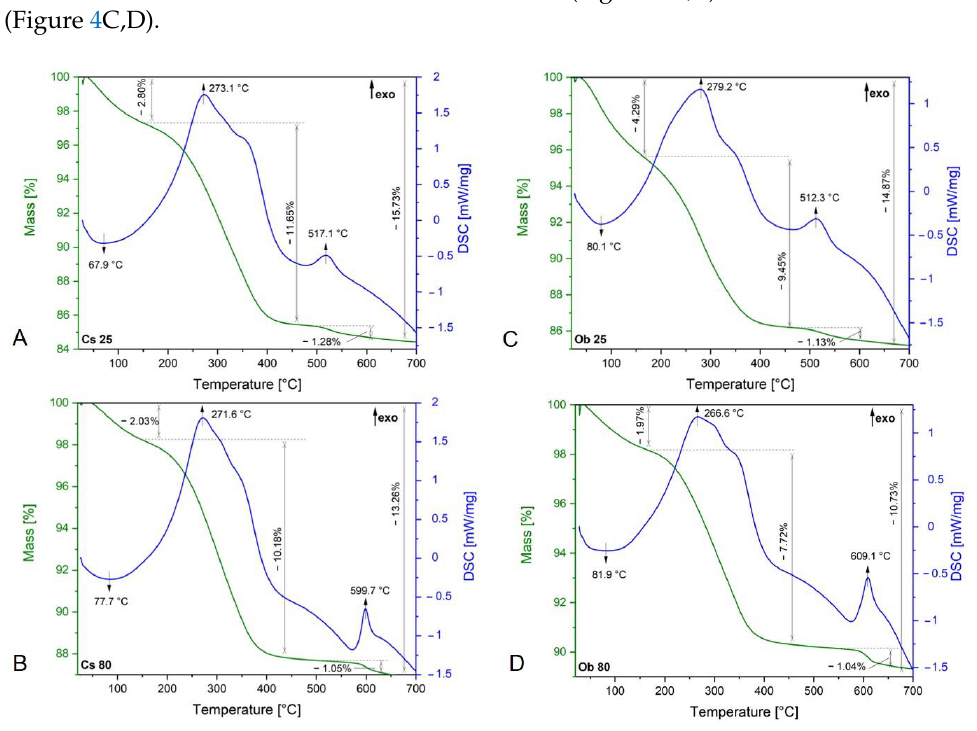
Figure 4. TG− DSC curves of MNPs obtained by green synthesis from Cs (green tea) and Ob (basil) ethanolic extracts, at 25 °C ( A , C ) and at 80 °C ( B , D